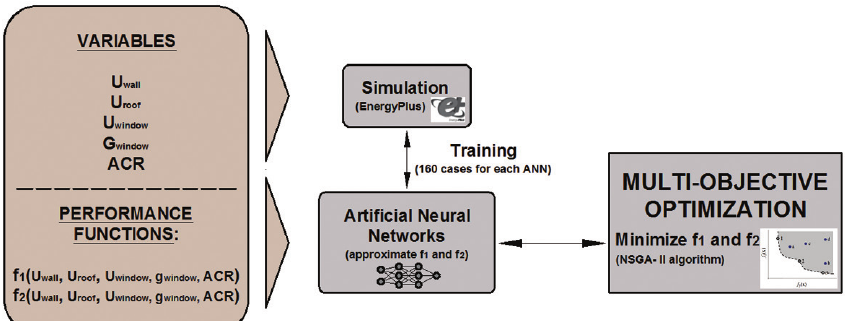
Fig. 2. Multi-objective optimization